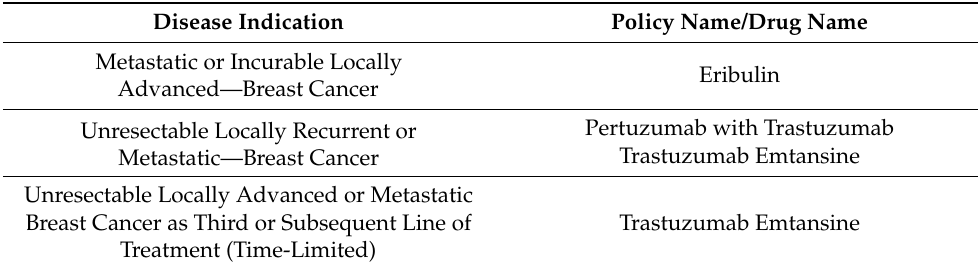
Table A5. Disease indications and funding policy name or name of drug received by patient that indicated a second breast cancer